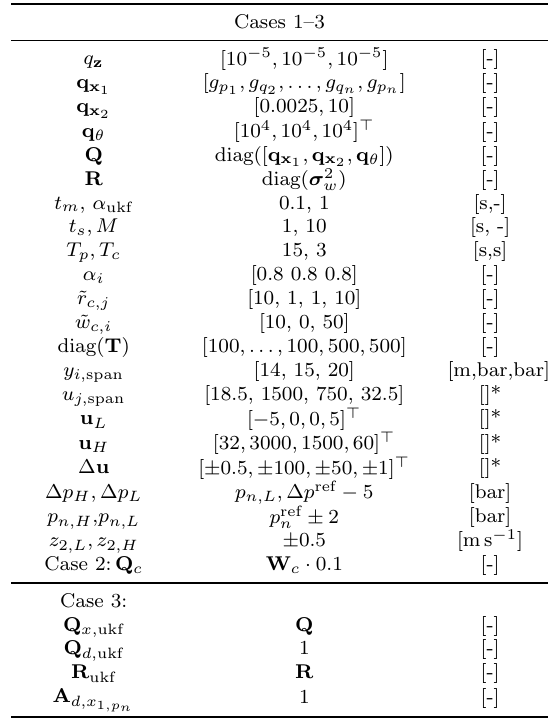
Table 6: Case 1–3 parameters.